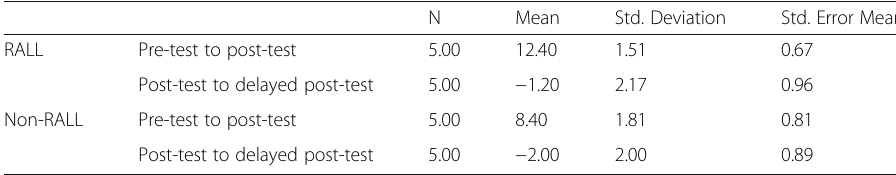
Table 4 Descriptive Statistics of English Vocabulary Gain Scores of RALL and non-RALL Groups N Mean Std. Deviation Std. Error Mean